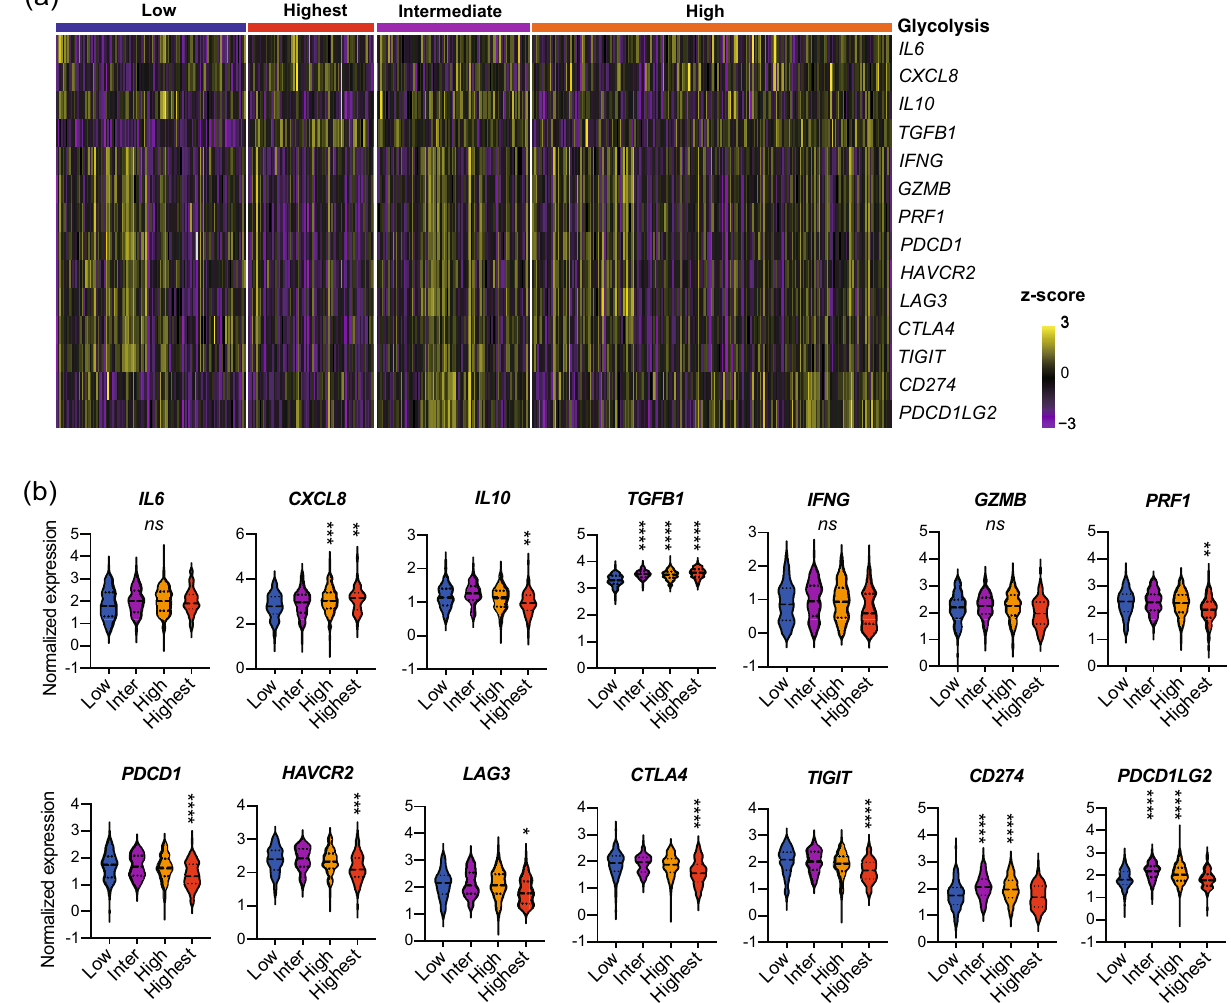
Figure 4. The expression profile of immune-related genes indicated increased immune evasion in glycolysis- upregulated tumors. ( a ) Heat map of immune-related gene expression in 520 patients with HNSCC obtained from TCGA database. ( b ) Violin plots of normalized gene expressions in the glycolysis groups shown in ( a ). The gene expressions in the glycolysis-intermediate, the glycolysis-high, and the glycolysis-highest group were compared to those in the glycolysis-low group.*, P < 0.05; **, P < 0.01; ***, P < 0.001; ****, P < 0.0001. HNSCC, head neck squamous cell carcinoma; TCGA, The Cancer Genome